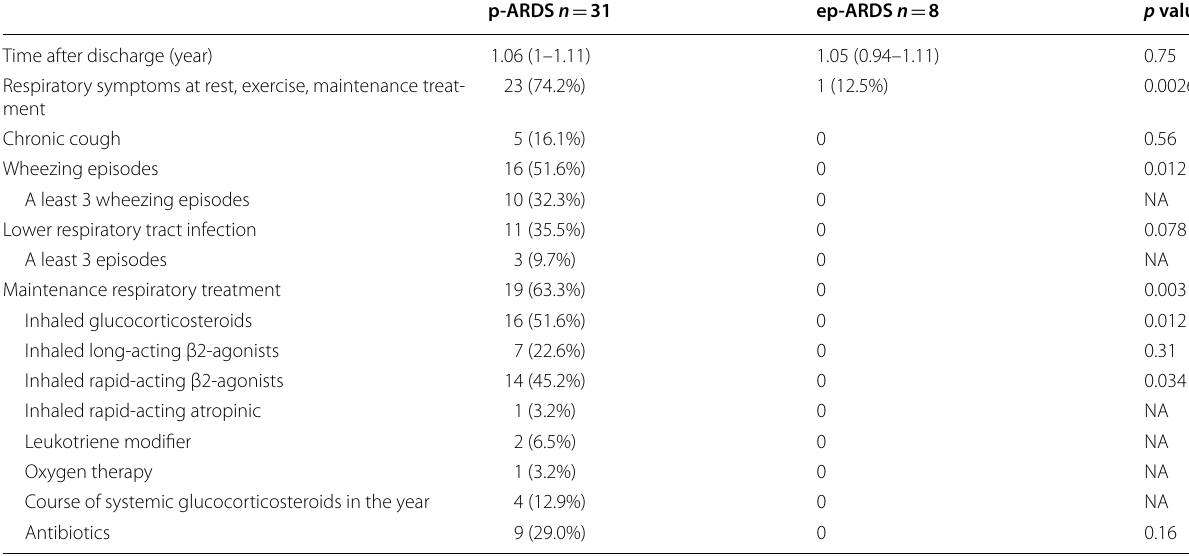
ep-ARDS extra-pulmonary ARDS, p-ARDS pulmonary ARDS. Results are medians (interquartile ranges) for quantitative variables, and frequencies and percentages for categorical variables